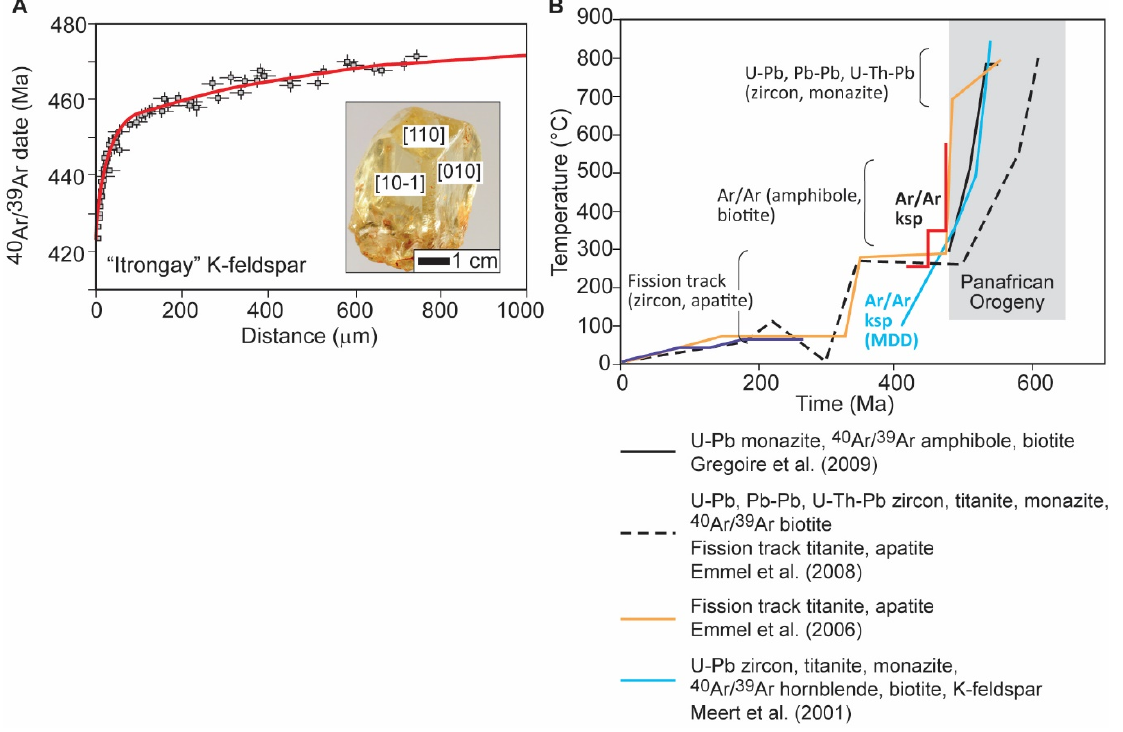
Figure 2. ( A ) Composite in situ 40 Ar/ 39 Ar date profile obtained from depth profiles from [010] and [110] crystal faces of gem quality alkali feldspar from Itrongay, Madagascar, with uncertainties of 1-sigma. Data were obtained by UV laser ablation, and are from Flude et al. (2014) [6]. ( B ) Flude et al. (2014) [6] interpret the data to reflect diffusive 40 Ar loss through a single length scale with a distance of at least 1cm, and derive a possible t-T solution (in red) using diffusion parameters that were previously obtained by Wartho et al. (1999) [34]. Flude et al. (2014) [6] suggest the accuracy of their t-T solution is supported by similarities with other t-T paths (shown) that have been derived for southern Madagascar using the U-Pb, 40 Ar/ 39 Ar and fission track methods.